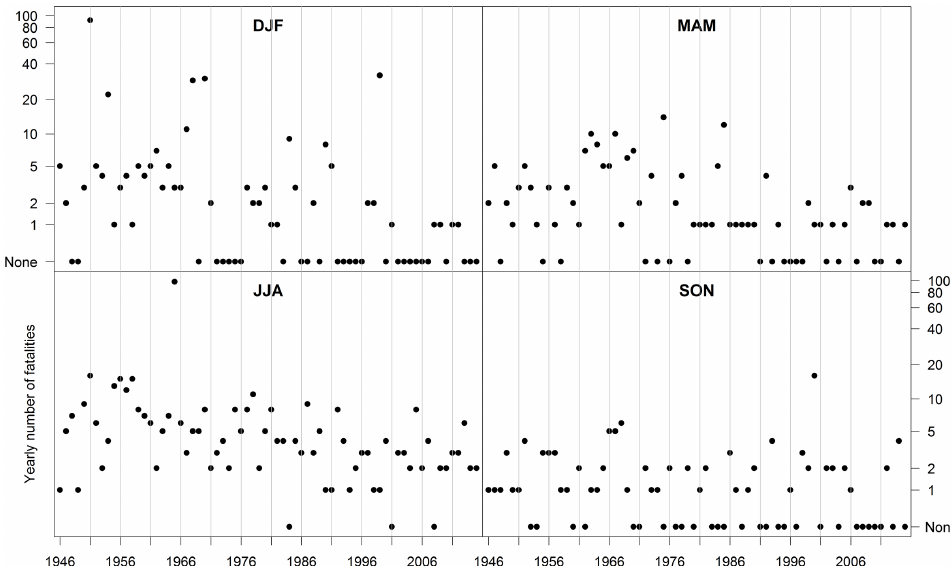
Figure 6. Annual frequency of total natural hazard fatalities in Switzerland from 1946 to 2015 for the four Northern Hemisphere seasons winter (DJF, top left), spring (MAM, top right), summer (JJA, bottom left) and autumn (SON, bottom right). Note that years with no fatalities in a certain season were assigned an arbitrary value of 0.5 for plotting purposes and are labelled “none” on the y axis.